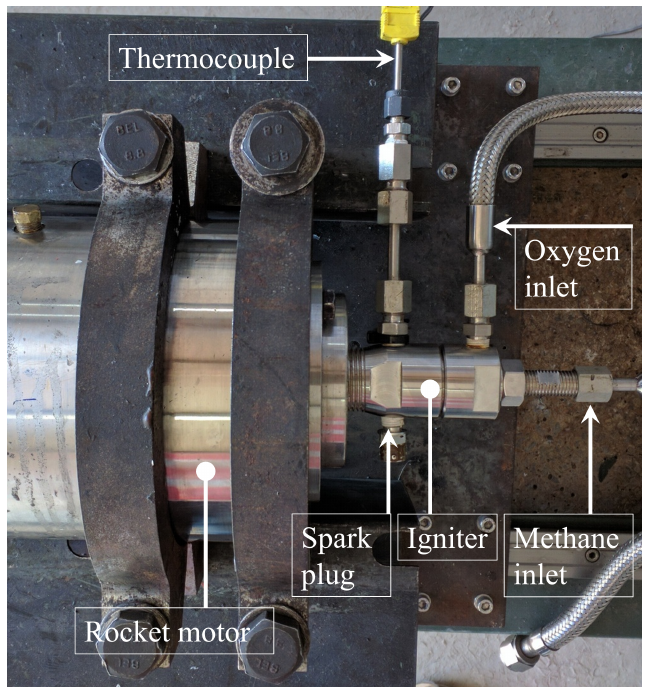
Figure 3. Igniter mounted on the test